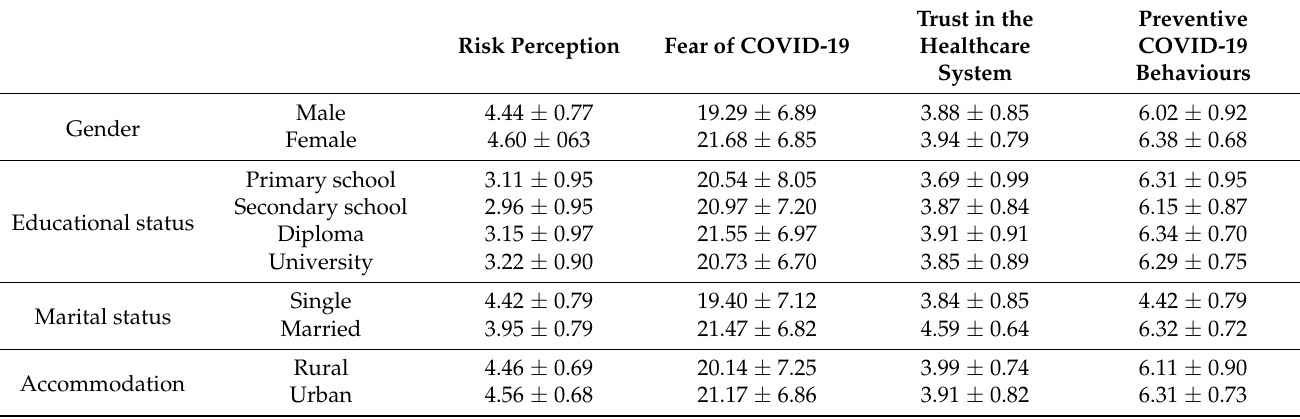
Table 2. Means and standard deviations of the measures according to the sociodemographic characteristics.